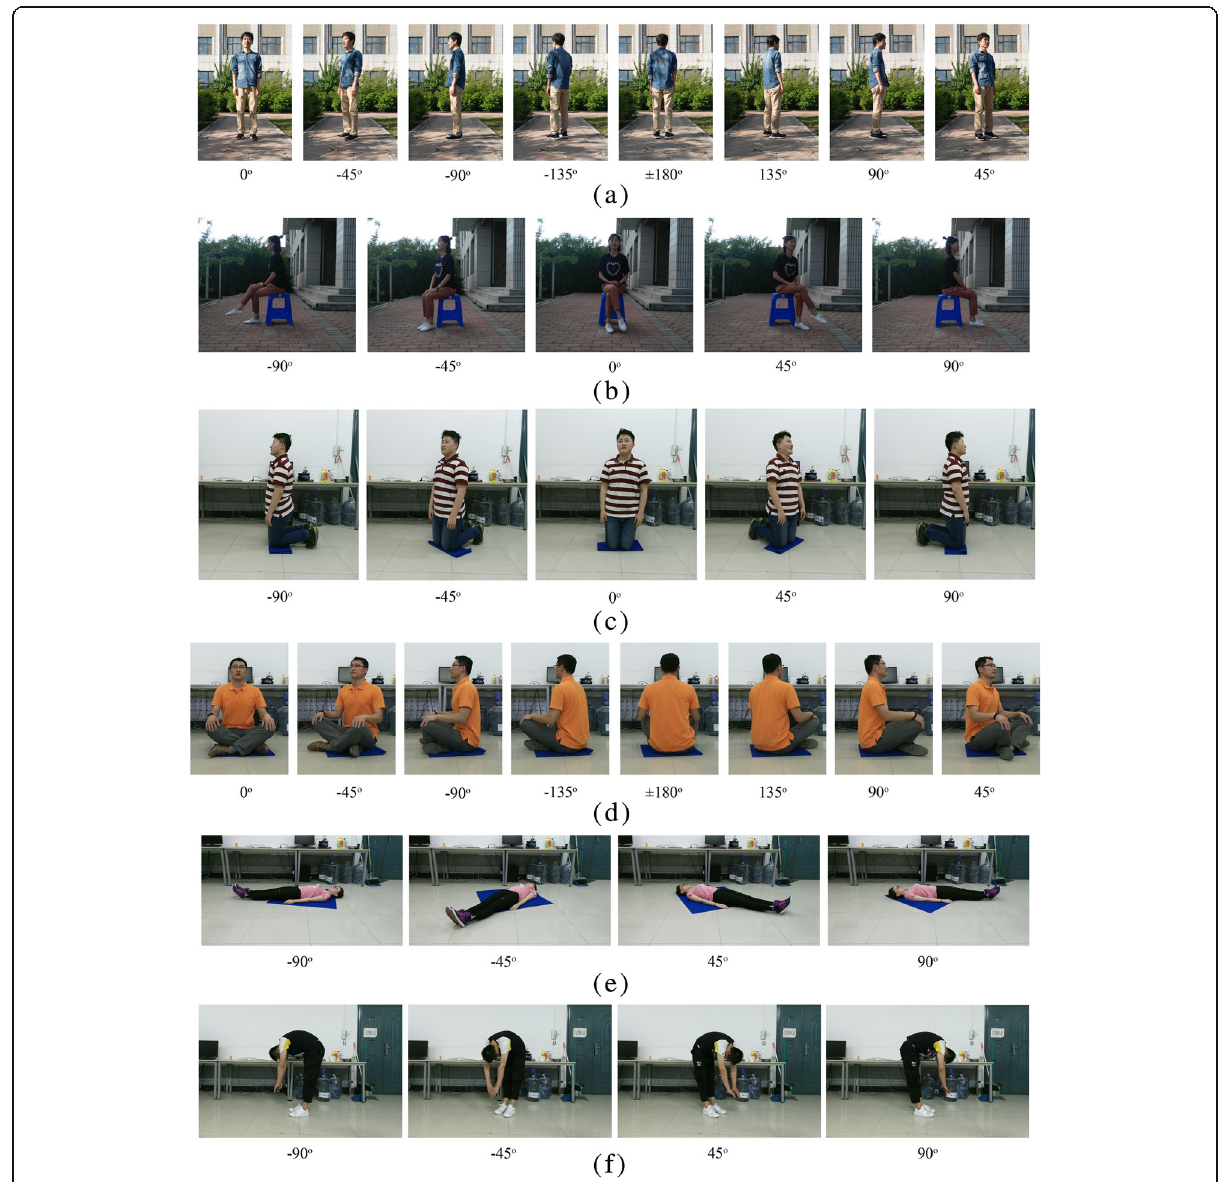
Fig. 16 Real depiction of human posture